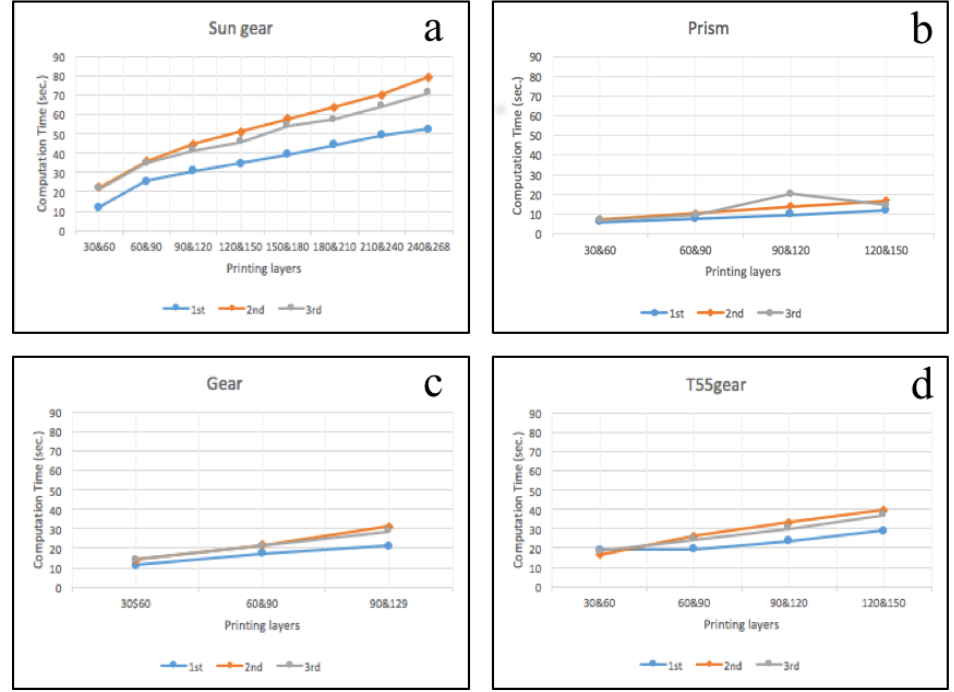
Figure 19. Error detection—Horizontal magnitude: the computation time of normal printing state for ( a ) sun gear; ( b ) Prism; ( c ) gear; and ( d ) t55gear. Failure Printing State